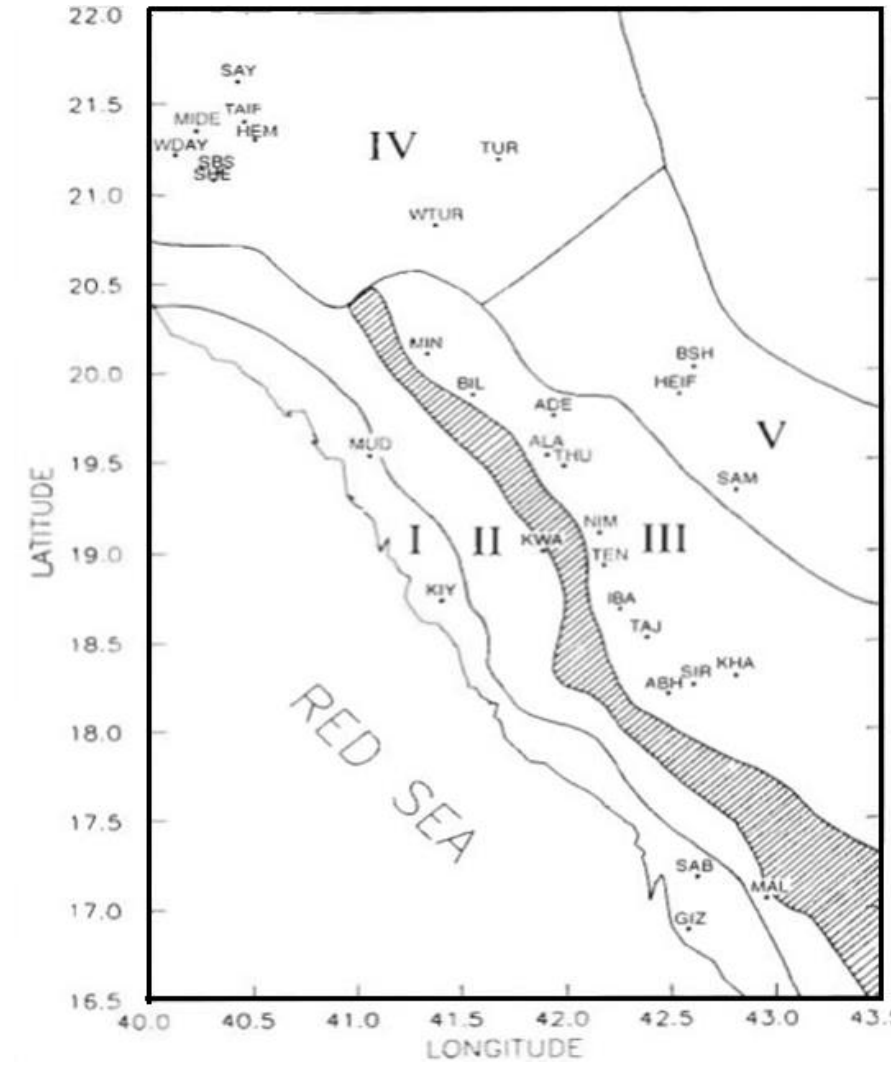
Figure 17. The five climatic regions in the southwestern part of Saudi Arabia, classified according to height above mean sea level